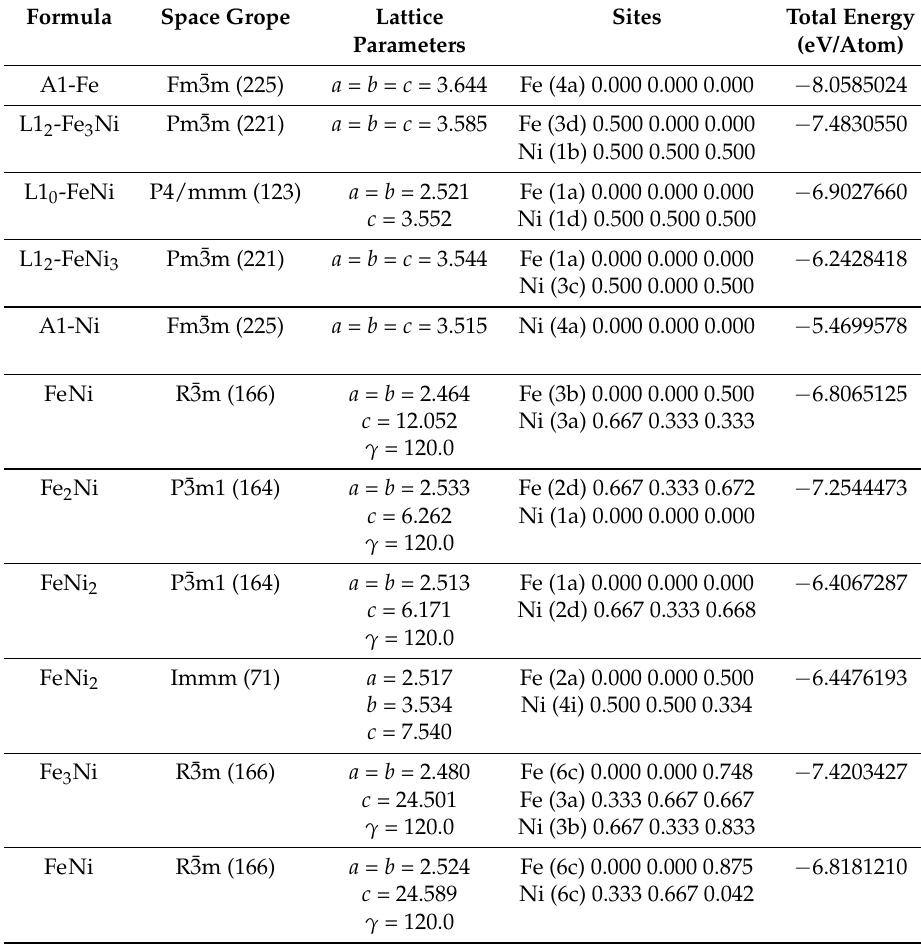
Table A1. Arrangement of elements and total